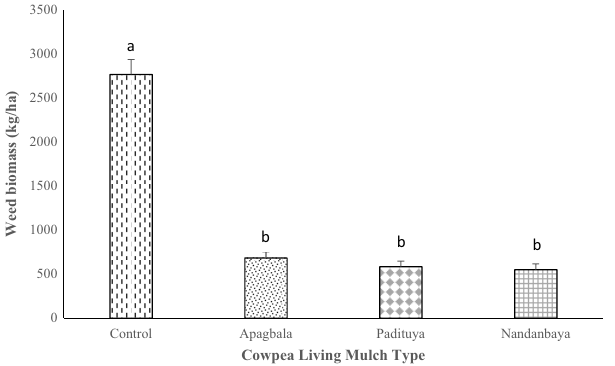
Figure 2: The e ff ect of cowpea living mulch types on weed biomass in maize plots ( average of 2017/2018 cropping season ) . Bars represent standard error of means and bars with di ff erent letters are signi fi cantly ( p < 0.05 ) di ff